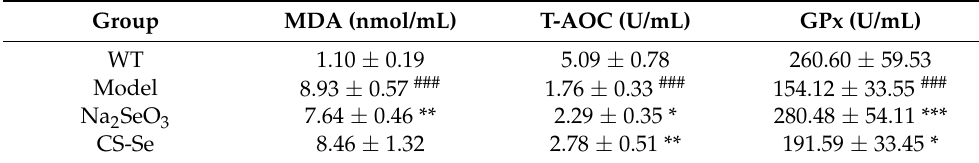
Table 1. Effect of CS-SeNPs and Na 2 SeO 3 on serum T-AOC, GPx activity and MDA content.